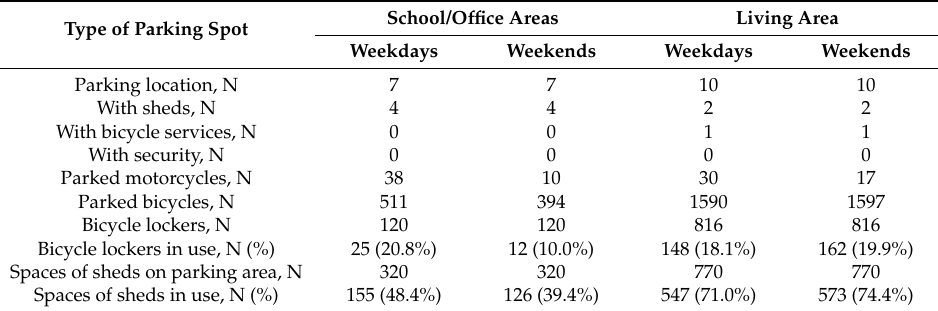
Table 4. Number of bicycle parking spots scanning on campus. Type of Parking